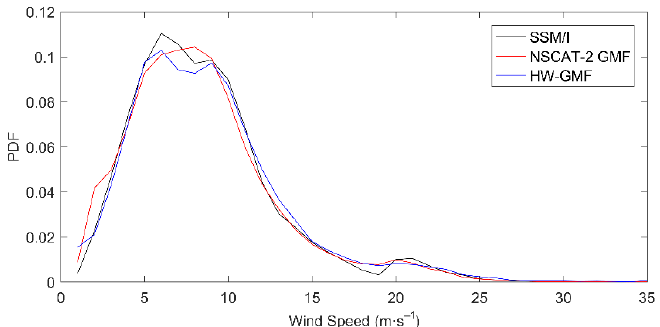
Figure 11. The probability density functions (PDFs) of HY ‐ 2A and SSM/I wind speed. The black line